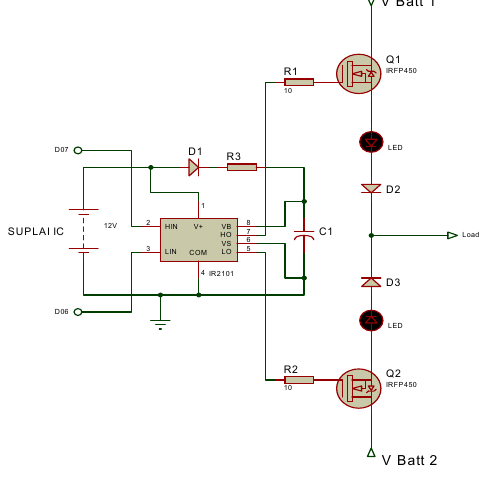
Figure 5. Voltage sensor circuit at load.